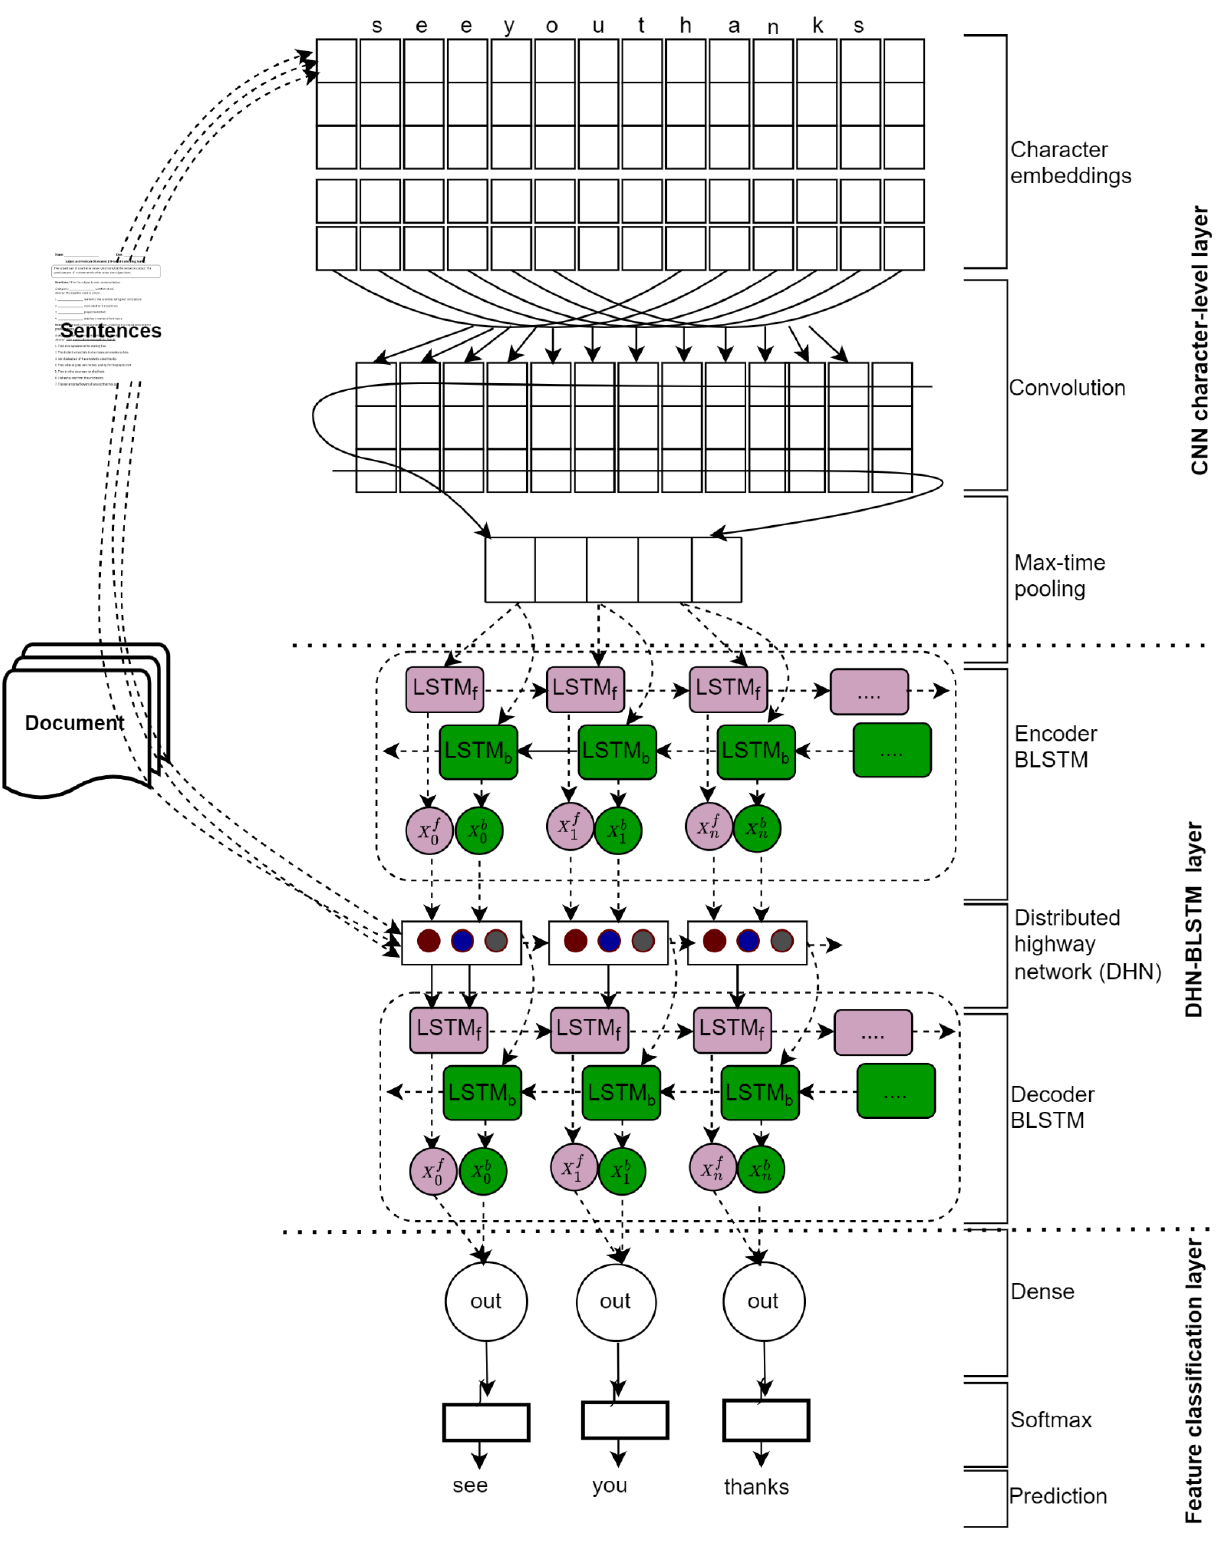
Figure 1. The architecture of the RDNN PAA system. The CNN character-level layer of the proposed RDNN method is a slight variant of the deep CNN character-level [92]. In the CNN layer, each word in a post is replaced with its one-hot vector representation. Hence, we denoted V to be the fixed vocabulary size of d being the dimensionality of character embedding, and X ∈ R d ×| V | to be the